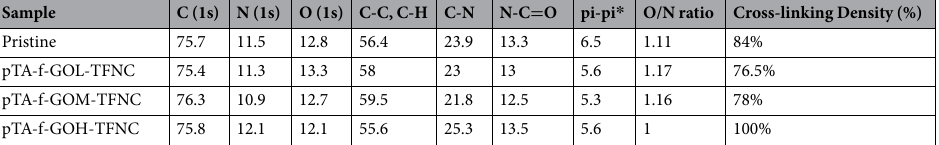
Table 1. The elemental compositions, O/N ratio, chemical functional groups % and degree of cross-linking of the TFC, hence m + n = 1.